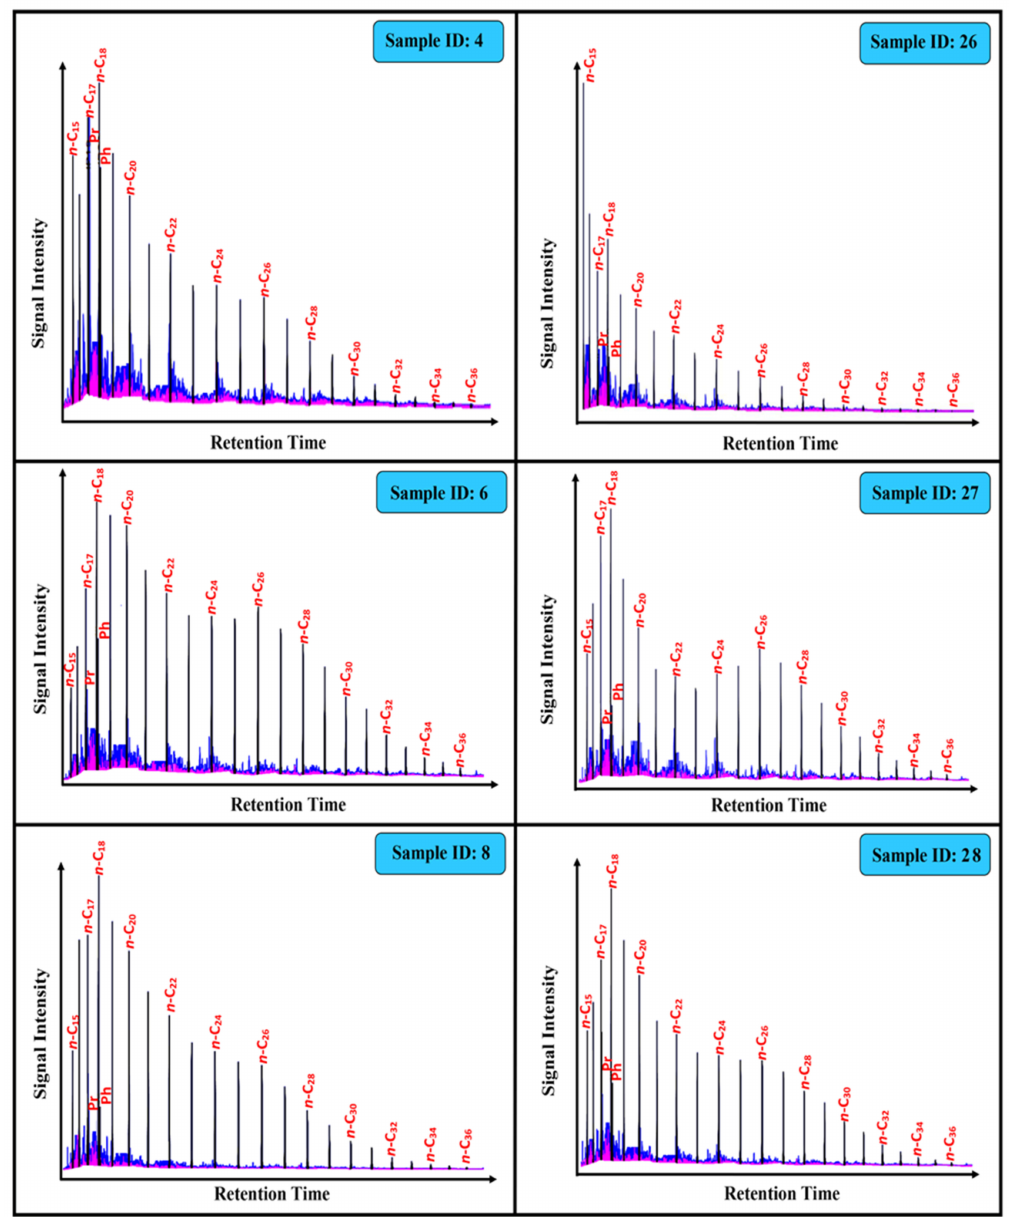
Figure 6. GC chromatography shows n-alkane and acyclic isoprenoid (e.g., pristane and phytane) distributions of the aliphatic hydrocarbon fraction in the analyzed shales of the Qusaiba